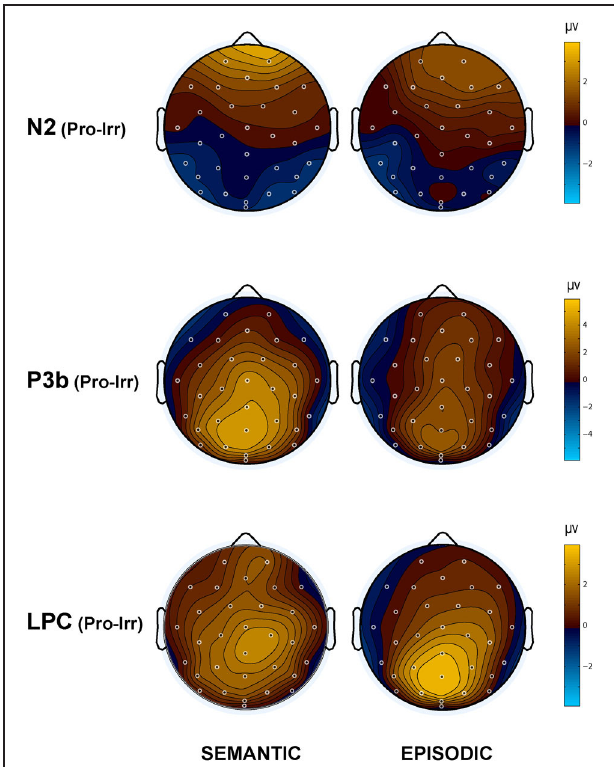
FIGURE 4 | Topographic maps of the ERP difference between probes and irrelevants for (top) the N2 (250–350 ms), (middle) P3b (400–600 ms), and (bottom) LPC (750–900 ms) in the semantic (left column) and episodic (right column) autobiographical conditions. An N400 map is not shown because there was no CIT effect in the episodic condition, and the P3b map for the semantic condition captures the N400 as a positive difference at Cz (28); thus, the centroparietal distribution in the P3b time period of the semantic condition reflects the combination of the overlapping central maximum of the N400 CIT effect and the parietal maximum of the P3b CIT effect. Note, the voltage scale is not the same for all topographic